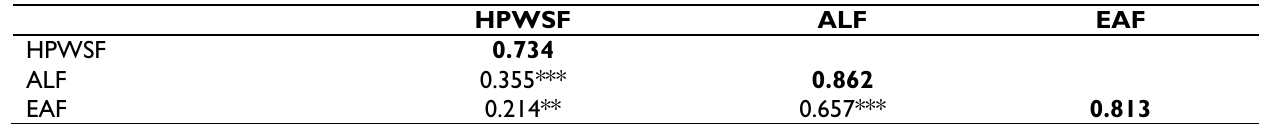
Table 5. Discriminant Validity of HPWS and EA